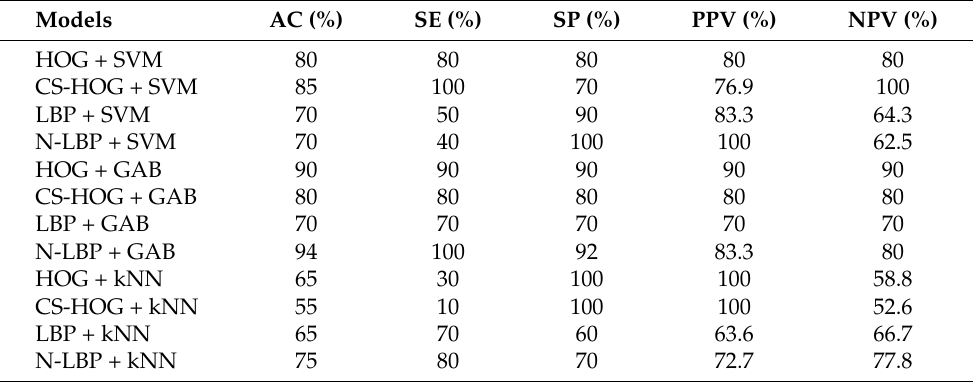
Table 1. Performance analysis of classifiers based on CS-HOG and HOG